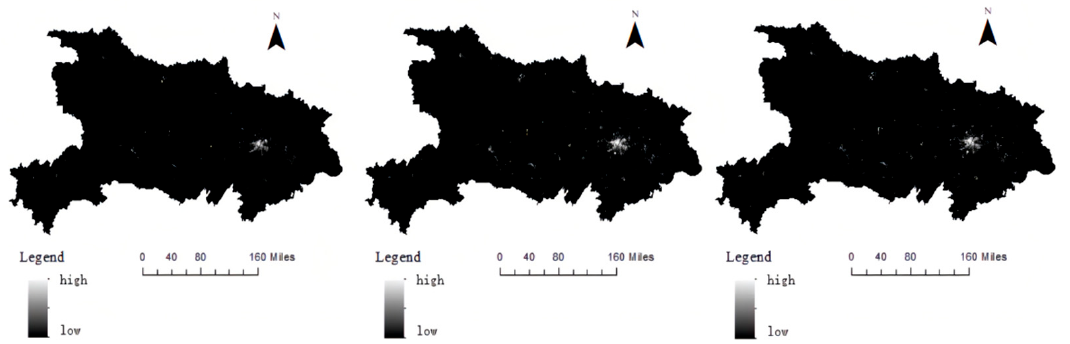
Figure 8. Night-light remote sensing images of Hubei province (from left to right, 2013, 2015, 2017).